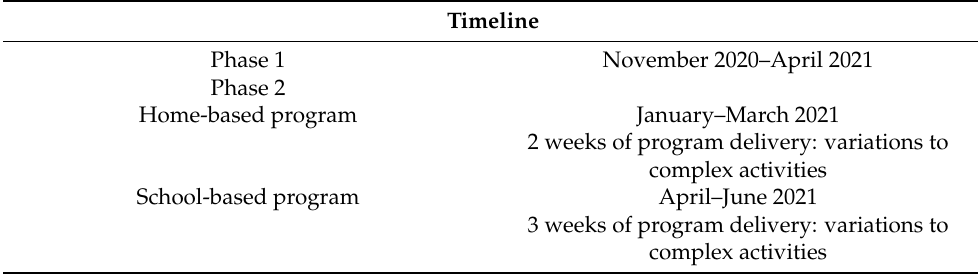
Table 1. Timeline of study components per